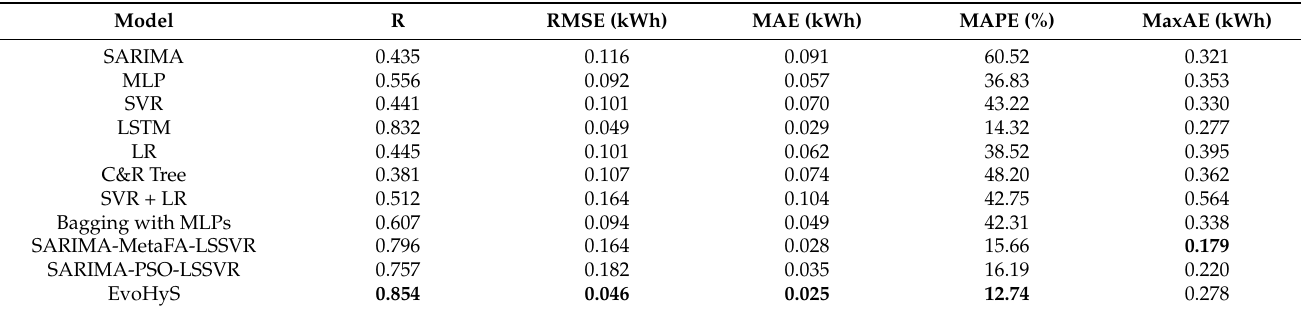
Table 3. The average values in terms of R, RMSE, MAE, MAPE, and MaxAE for EvoHyS and literature models. The best values are highlighted in bold.